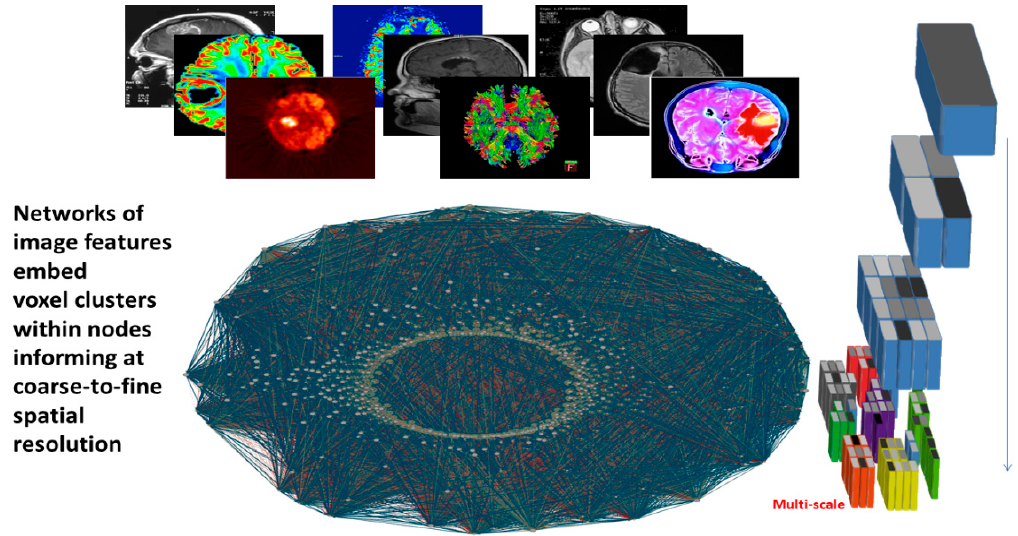
Figure 3. Multiscale information network processing from image features.